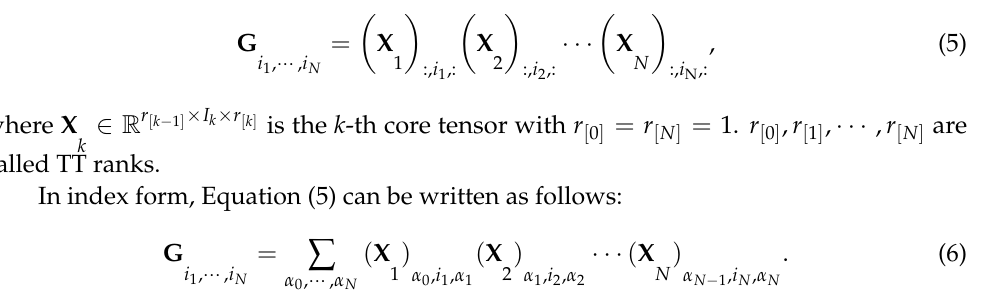
Figure 1. Graphical representation of tensor manipulations. ( a ) Basic building blocks for tensor network diagrams; ( b ) mode-2 matricization (left), mode-(1,2) matricization (middle), and vector- ization (right) of a 3-order tensor